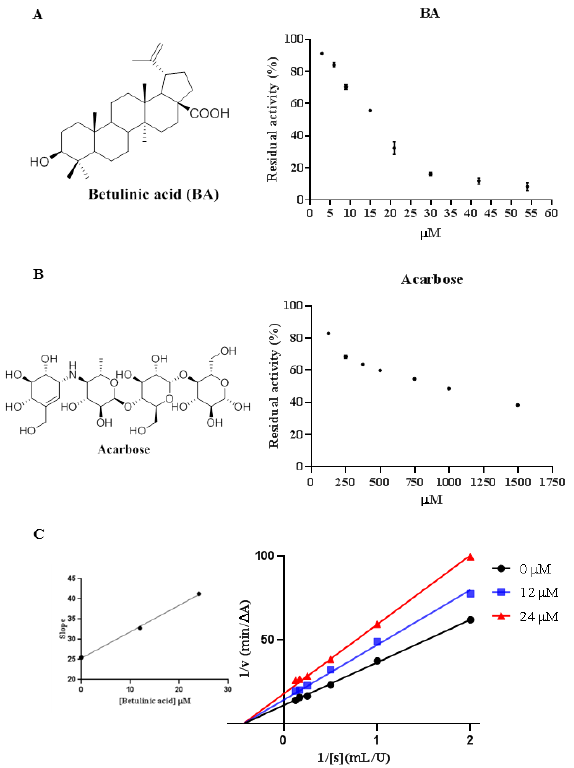
Figure 1. ( A ) Chemical structure of betulinic acid ( BA ) and its inhibitory effect of BA against α -glucosidase; ( B ) Chemical structure of acarbose and its inhibitory effect of acarbose against α -glucosidase; ( C ) Line-weaver-Burk diagrams (1/V vs. 1/[S]) for BA against α -glucosidase. The secondary plot of slope vs. BA was included.